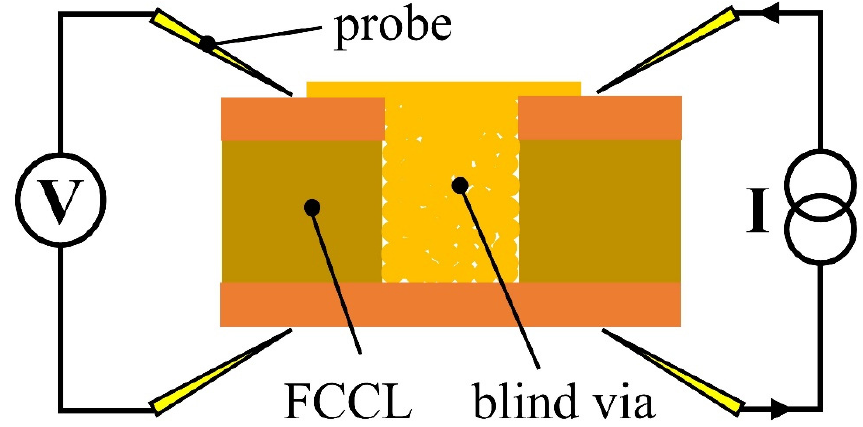
Figure 3. Schematic of the four-point probe measurement method.